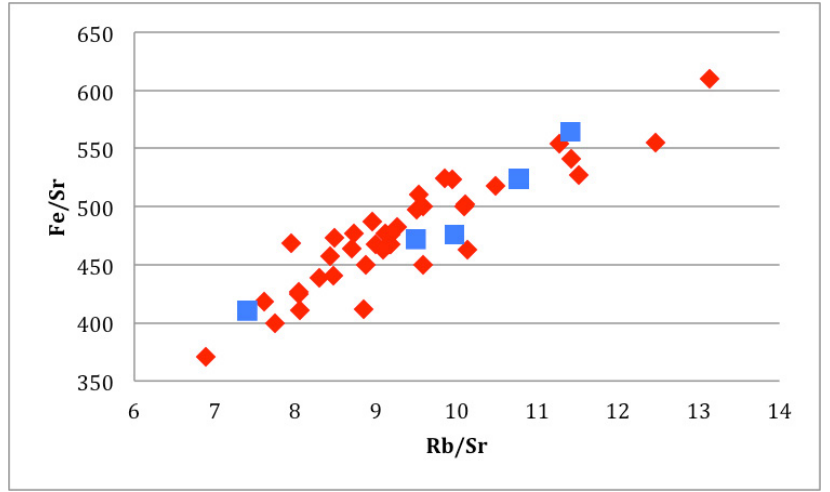
Figure 2a. Fe/Sr vs Rb/Sr. Stromboli: red diamonds; SdP, Lipari reference obsidian: blue squares. The latter fall within the Stromboli collection group. The SdP obsidian does not constitute an obsidian source, merely presence thereof.